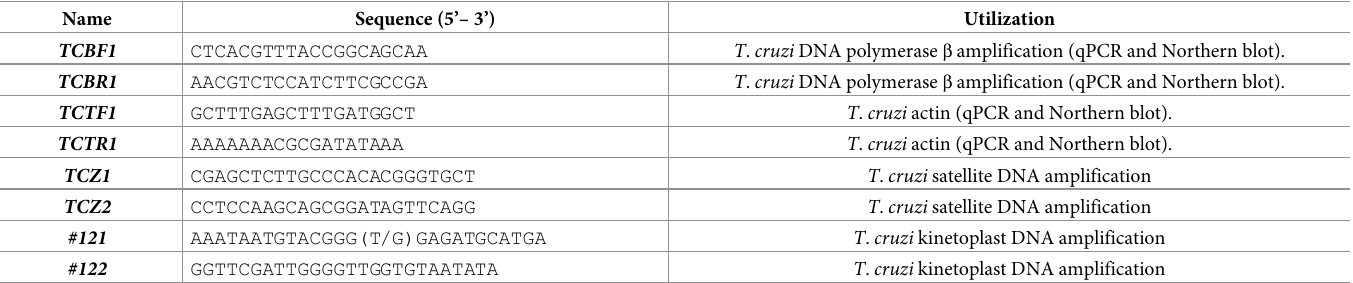
Table 1. Oligonucleotides used in this